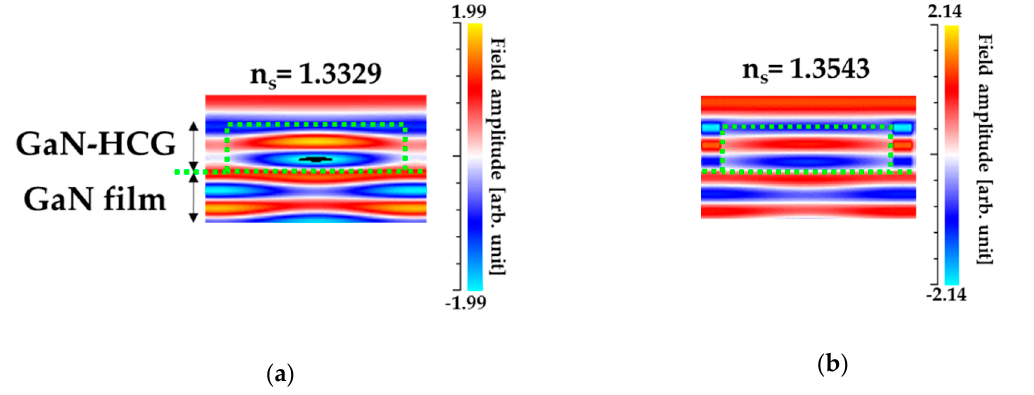
Figure 11. The calculated magnetic field profile at the wavelength of 415 nm with ( a ) n s = 1.3329 (water) ( b ) n s = 1.3543. The amplitudes were normalized by that of the incident light.